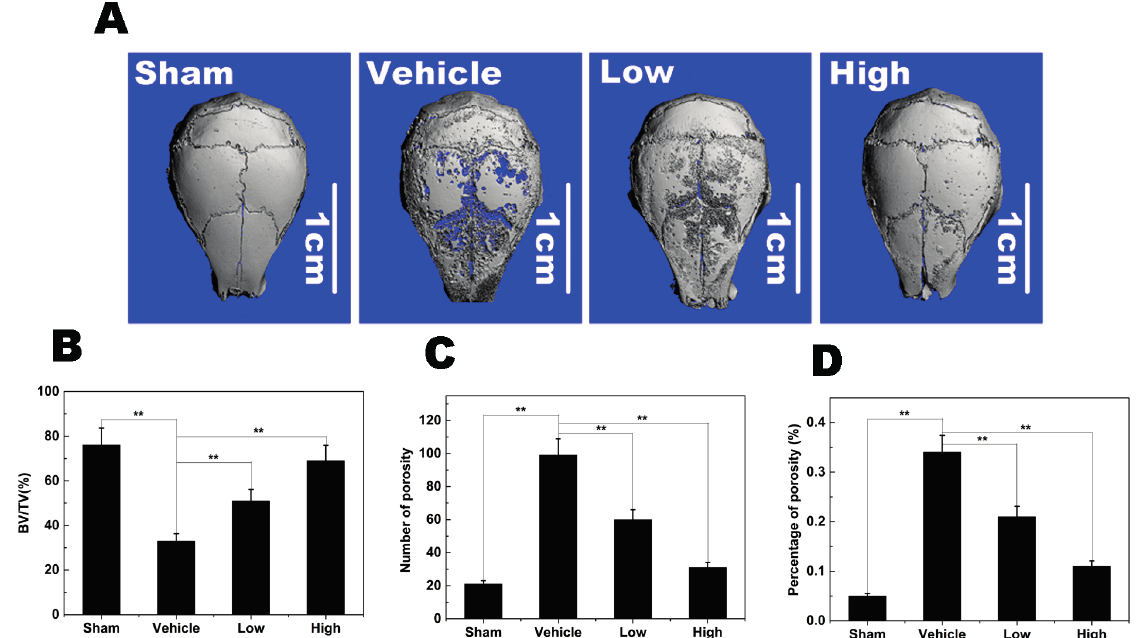
Figure 9. Naringenin (NAR) attenuated titanium (Ti) particle-induced mouse calvarial osteolysis. ( A ) Representative micro-computed tomography (CT) three-dimensional images from each group; ( B ) bone volume/tissue volume ratio (BV/TV); ( C ) number of pores; ( D ) the percent porosity in each sample. ** p <